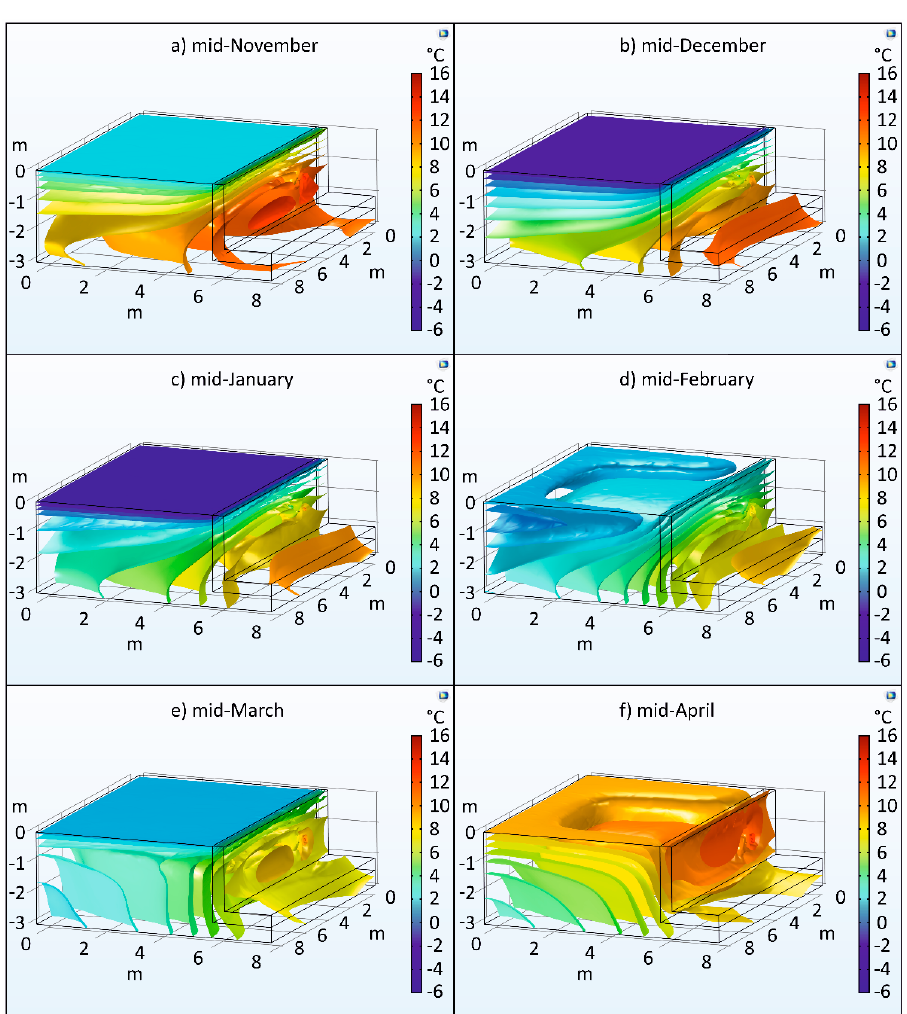
Figure 6. The tri-dimensional temperature isosurfaces for the simulation case 2—HGHE with a heated basement: ( a ) mid-November; ( b ) mid-December; ( c ) mid-January; ( d ) mid-February; ( e ) mid-March; ( f ) mid-April.